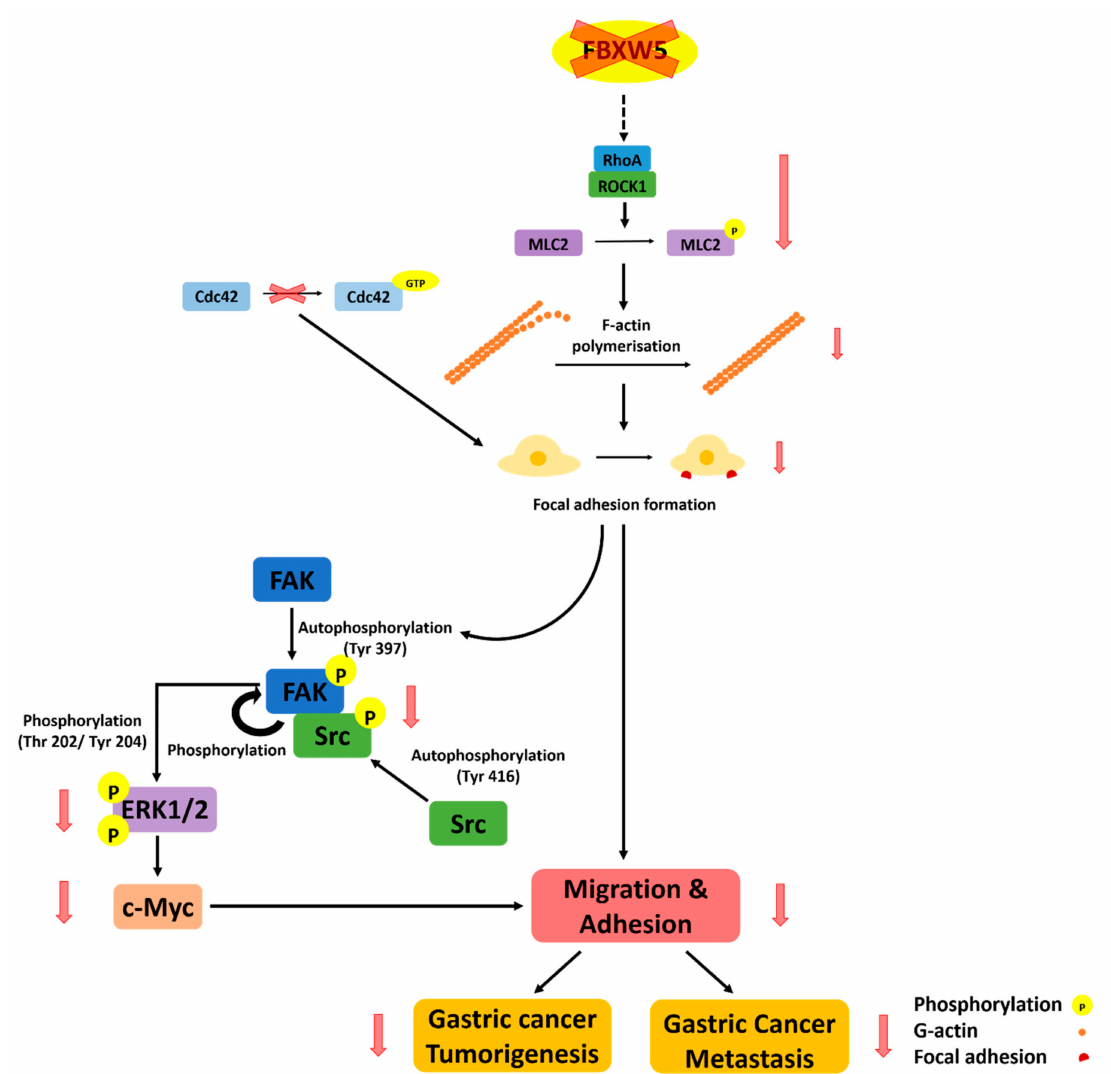
Figure 7. A graphical illustration of the proposed mode of FBXW5-induced regulation of intracellular signaling in gastric